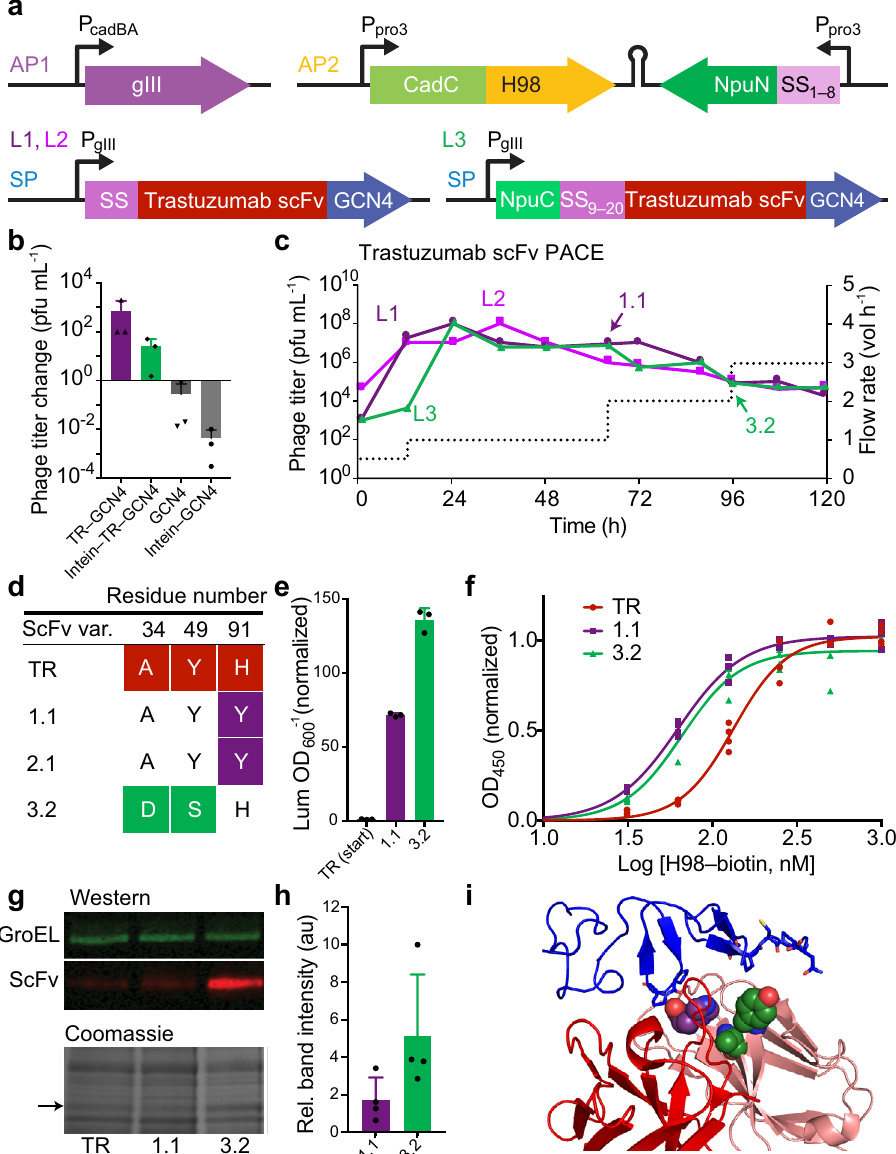
Fig. 5 Evolution of trastuzumab variants with improved binding to a Her2-mimetic peptide. a Components of the second-generation periplasmic PACE system to evolve trastuzumab. The H98 peptide is a structural homologue of the Her2 epitope. A C-terminal dimeric GCN4 peptide directs dimerization of scFvs. b Phage propagation assay of starting genotypes and negative controls. Sequences with intein-split SS are indicated as ‘ intein ’ . c PACE was carried out over 120h using full-length (lagoons L1 − L2, purple) or split-intein signal sequence (lagoon L3, green). By 96h, all three lagoons converged on discrete solutions, shown in ( d ) and in Supplementary Fig. 10a. e Luminescence assay with trastuzumab (abbreviated TR, red) and evolved trastuzumab variants